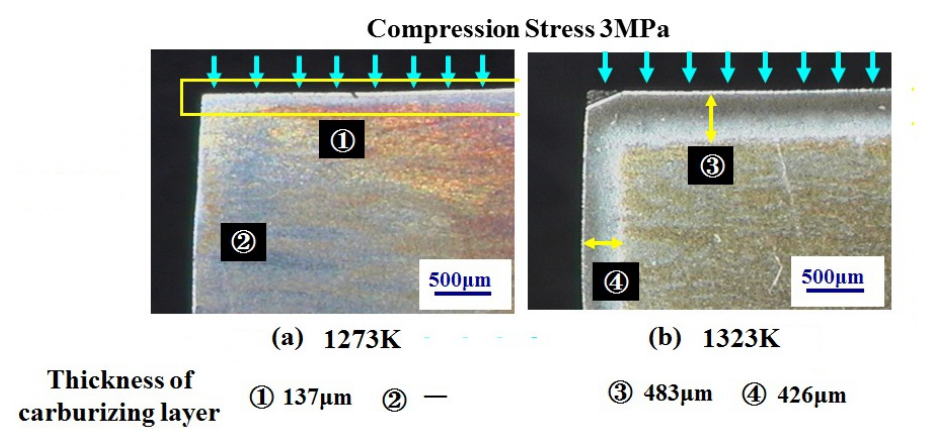
Figure 10. Micrograph of compression and non-compression faces carburized at ( a ) 1273 and ( b ) 1327 K,